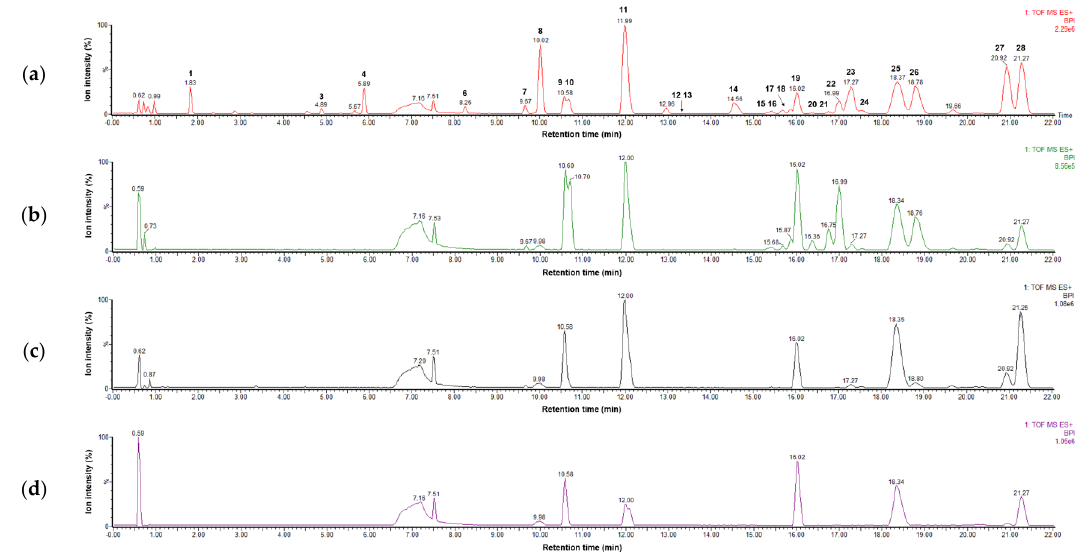
Figure 1. LC – MS base peak ion chromatograms of four extracts representing ( a ) flowers (S3), ( b ) roots (S15), ( c ) leaves (S9), and ( d ) stems (S21) of Peucedanum japonicum in positive ion mode (6 eV, ESI + ). Table 1. Characterization and tentative identification of coumarins found in Peucedanum japonicum using UPLC-QTof MS.